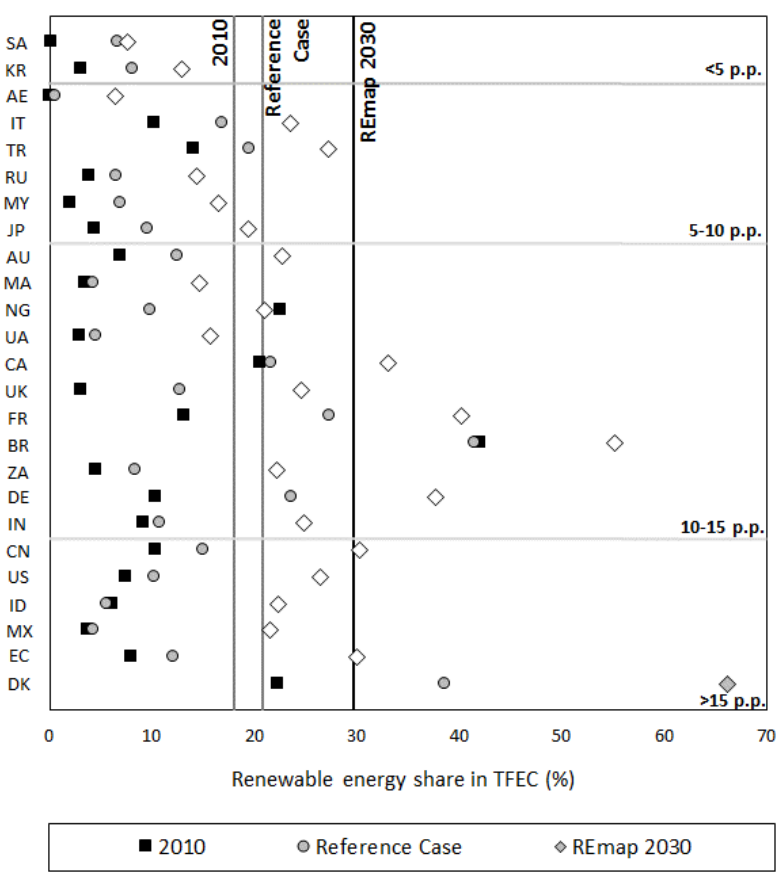
Figure 2. RE share of REmap countries in 2010, and for the Reference Case and for REmap Options in 2030. Vertical lines indicate the global RE share in 2010 and in 2030 Reference Case (grey lines) and REmap 2030 (black line). Areas between the horizontal lines represent the categories of growth in RE share between 2030 Reference Case and REmap 2030 (in percentage points, p.p.). Countries are abbreviated as follows: Australia (AU), Brazil (BR), Canada (CA), China (CN), Denmark (DK), Ecuador (EC), France (FR), Germany (DE), India (IN), Indonesia (ID), Italy (IT), Japan (JP), Malaysia (MY), Mexico (MX), Morocco (MA), Nigeria (NG), Russia (RU), Saudi Arabia (SA), South Africa (ZA), South Korea (KR), Turkey (TR), Ukraine (UA), United Arab Emirates (AE), United Kingdom (UK), and United States